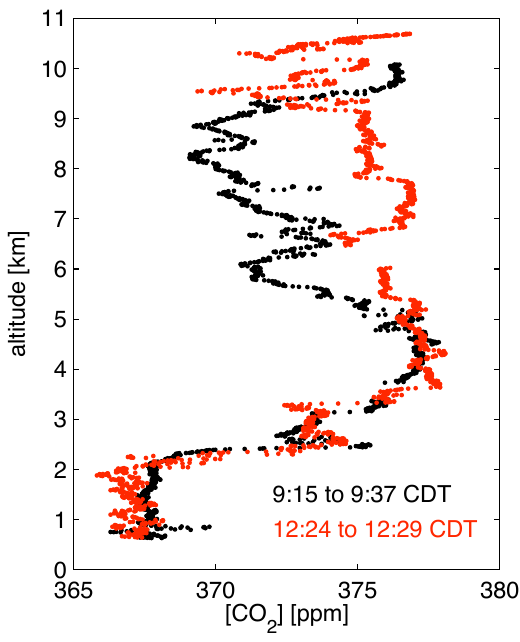
Fig. 6. Two profiles obtained above Park Falls on 15 July 2004 Fig. 7. Fifteen months of daily median h CO 2 i at Park Falls and La- within three hours during the INTEX-NA campaign. A frontal sys- mont. We see the impact of large-scale gradients in these two time- tem moved through the region between the profiles, leading to a series: the records are similar outside the growing season (when ∼ 5ppm increase in free tropospheric [CO north-south gradient in CO 2 is small) and the records diverge dur- 2 ] between 5–9km. The decrease in boundary layer [CO 2 ] is notably smaller. ing the growing season (June–August) when CO 2 is drawn down in the north. When the north-south gradient is larger, synoptic scale variations in daily median h CO 2 i are larger, reflecting the fact that variations arise from advection of